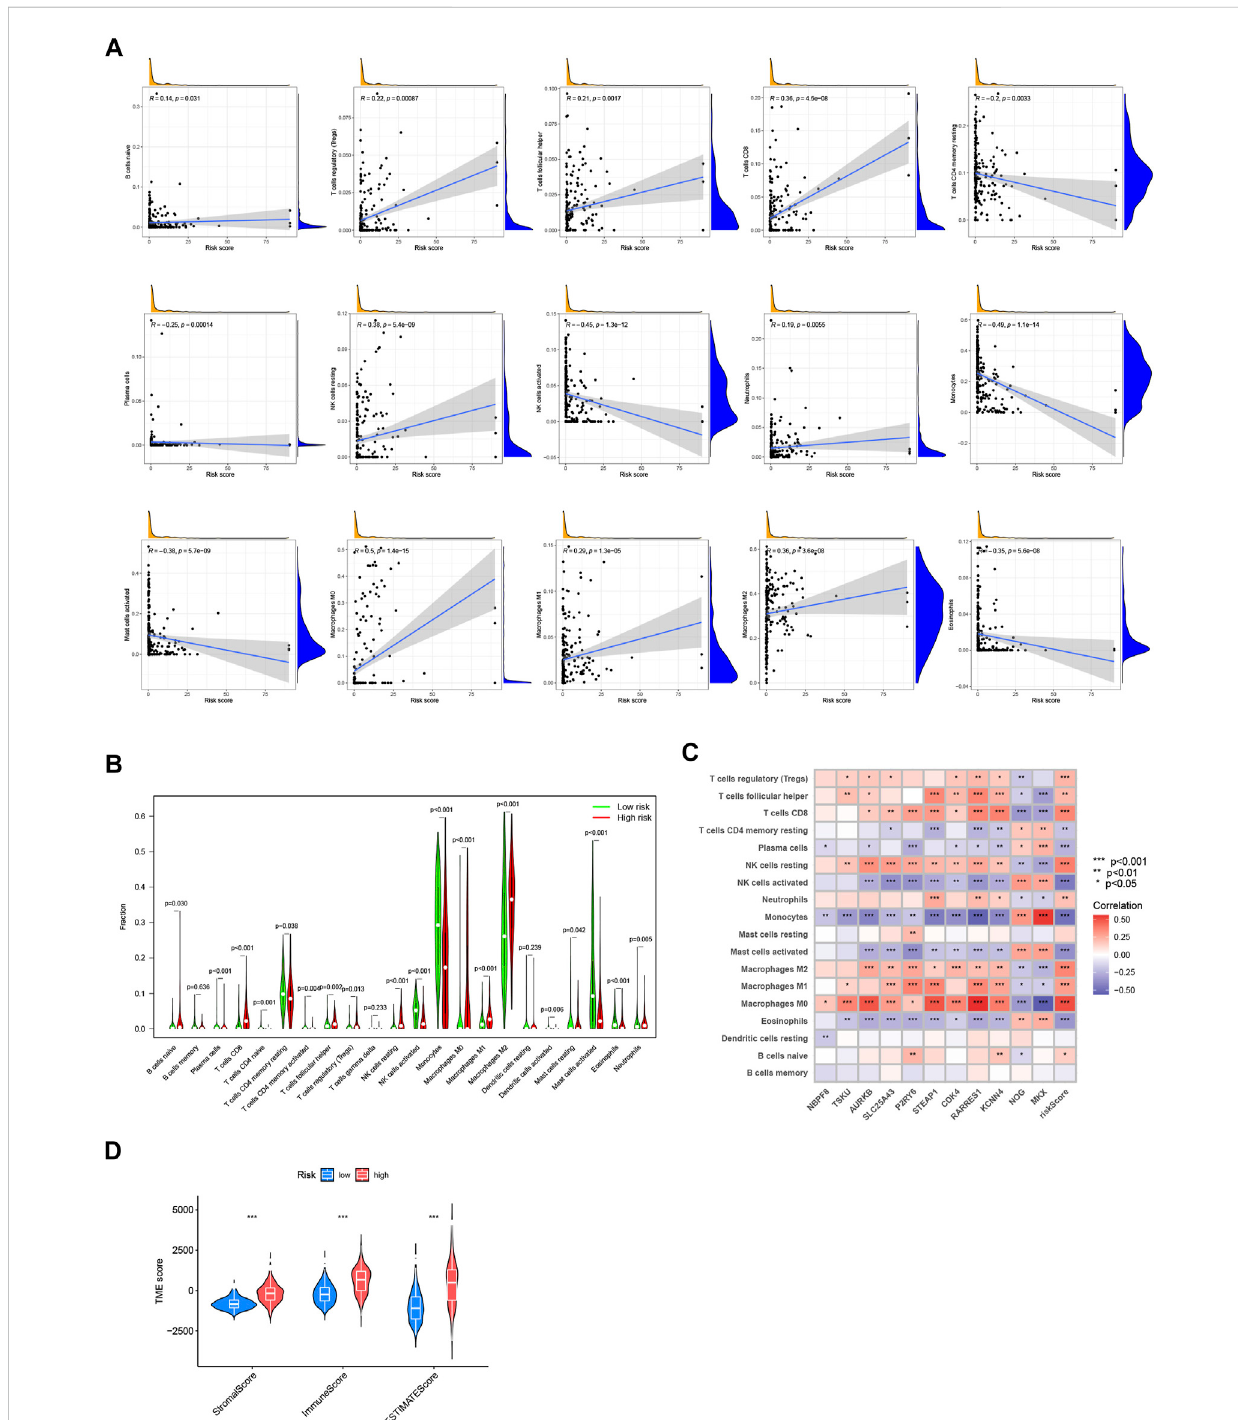
FIGURE 6 EvaluationofimmunecorrelationandTME. (A) TheconnectionsbetweenCRG-scoreandimmunecellsabundance. (B) WilcoxontestofCRG-score and immune cells abundance. (C) The connections betweenthegenes in CRG-score model and abundanceof immune cells. (D) The TMEscore of2 risk groups. (* p < 0.05; ** p < 0.01; *** p <